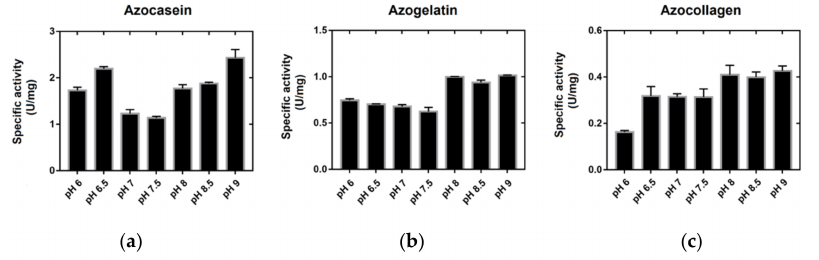
Figure 1. Specific activity (U/mg) of A. platensis lysate in pH 6 to 9 and substrate ( a ) azocasein, ( b ) azogelatin and ( c ) azocollagen. The data represent the mean ± SD (N =